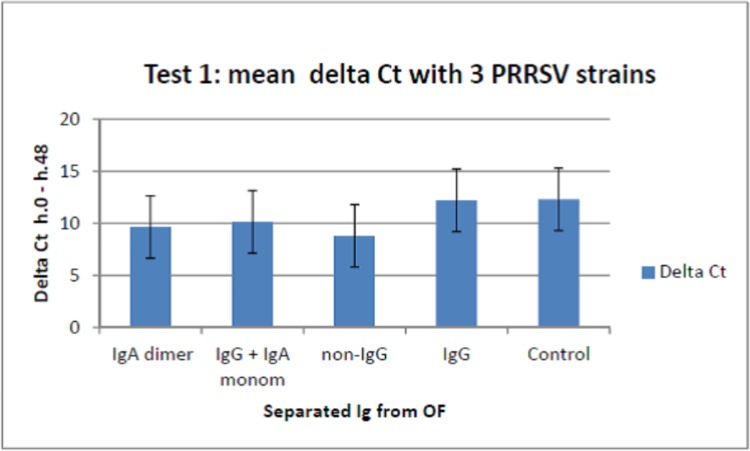
Yield reduction assay in PAM, test 1.Ig fractions were separated from a pool of antibody-positive OF samples (s/p IgA: 2.73; s/p IgG: 3.13) and used in a yield reduction assay on PAM. Results are shown in terms of mean genome copies/ml for PRRSV strains 433/5, 009/8 and 377 ± 1 standard deviation. Separated Ig significantly differed for antiviral activity (P< 0.001; P< 0.05 for non-IgG fraction vs. IgG, and monomeric IgA/IgG vs. IgG).